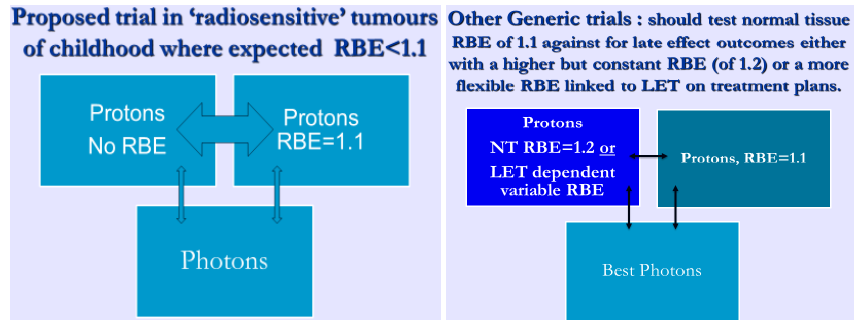
Figure 7. The proposal to randomise between a tumour RBE of 1 against a tumour RBE of 1.1 in radiosensitive tumours. Also, and in other studies of tumours of normal or reduced radiosensitivity, randomisation between an RBE of 1.2 (or higher) in late reacting normal tissues compared with 1.1 should also be considered.